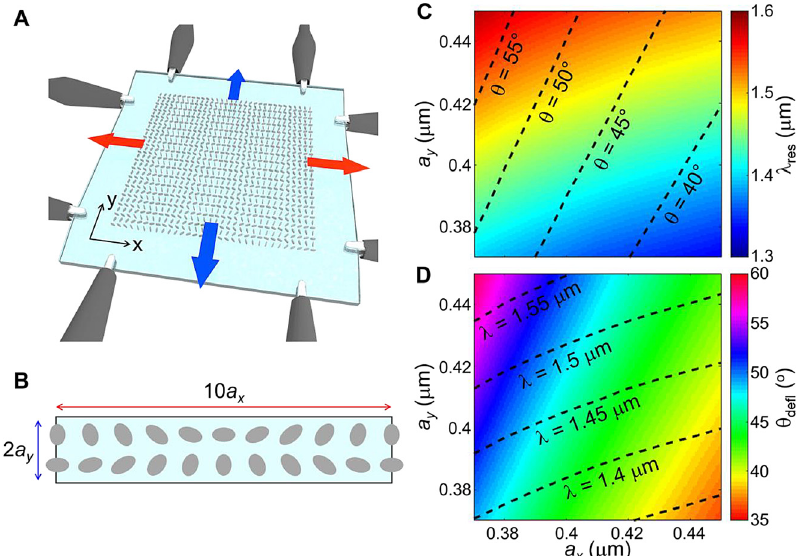
Figure 6: Design of mechanically tunable nonlocal